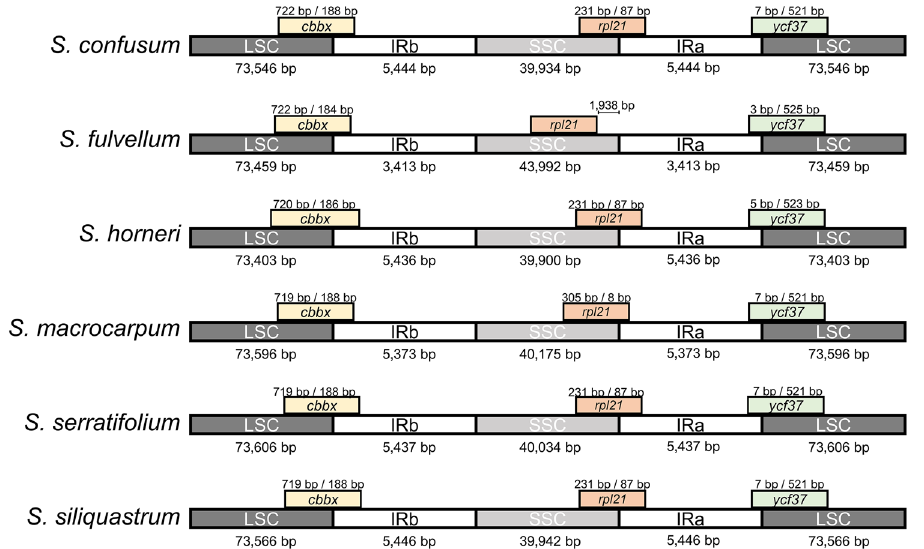
Figure 2. Comparison of the borders of large single copy (LSC), small single copy (SSC) and inverted repeat (IR) regions among the six Sargassum chloroplast